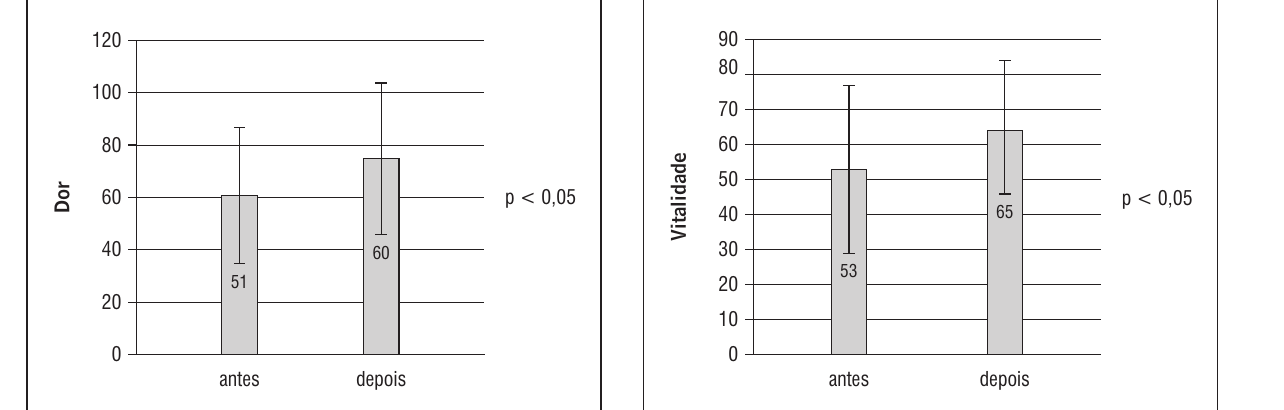
Figura 3 - Média e desvio-padrão do nível de dor dos pacien- tes antes e depois do protocolo fisioterapêutico (n = 27; p < 0,05)